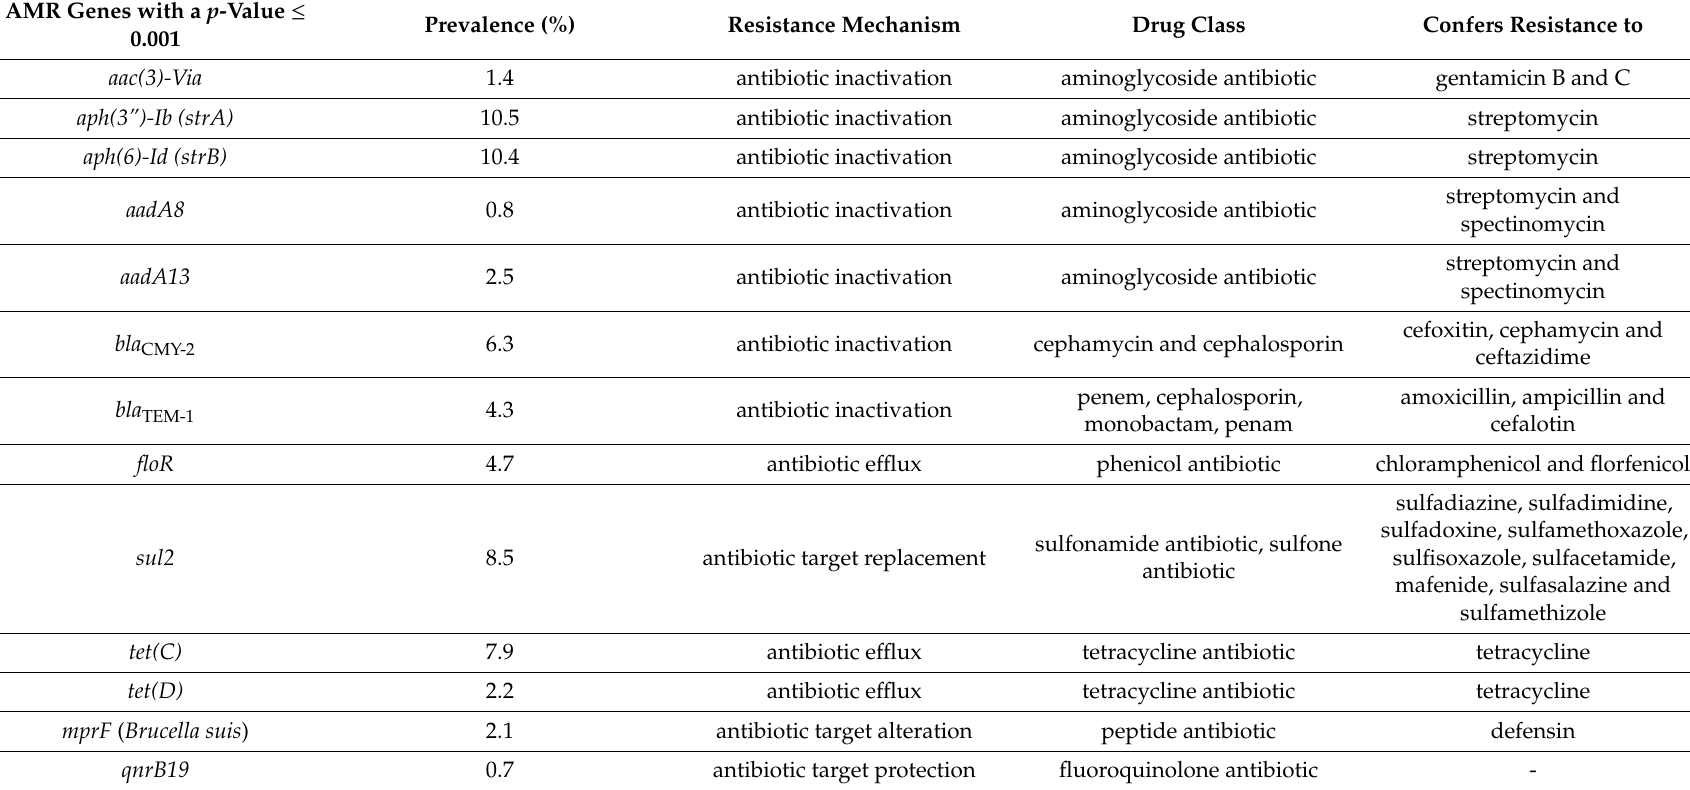
Table 2. Additional antimicrobial genes found in the S. enterica